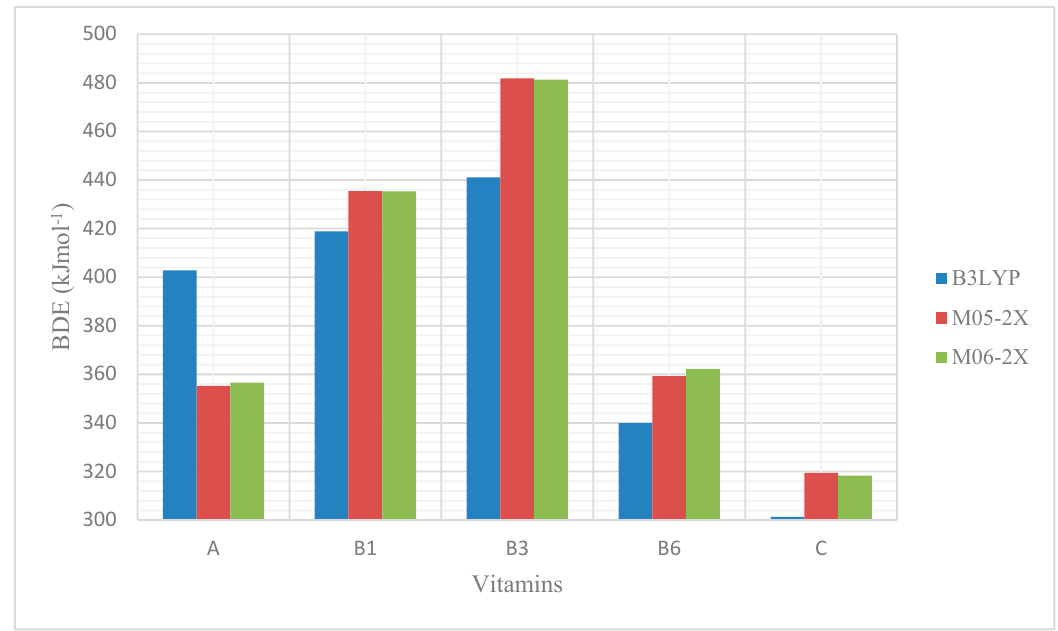
Figure 3. Comparison of bond dissociation enthalpies (BDE) of the dietary vitamins.